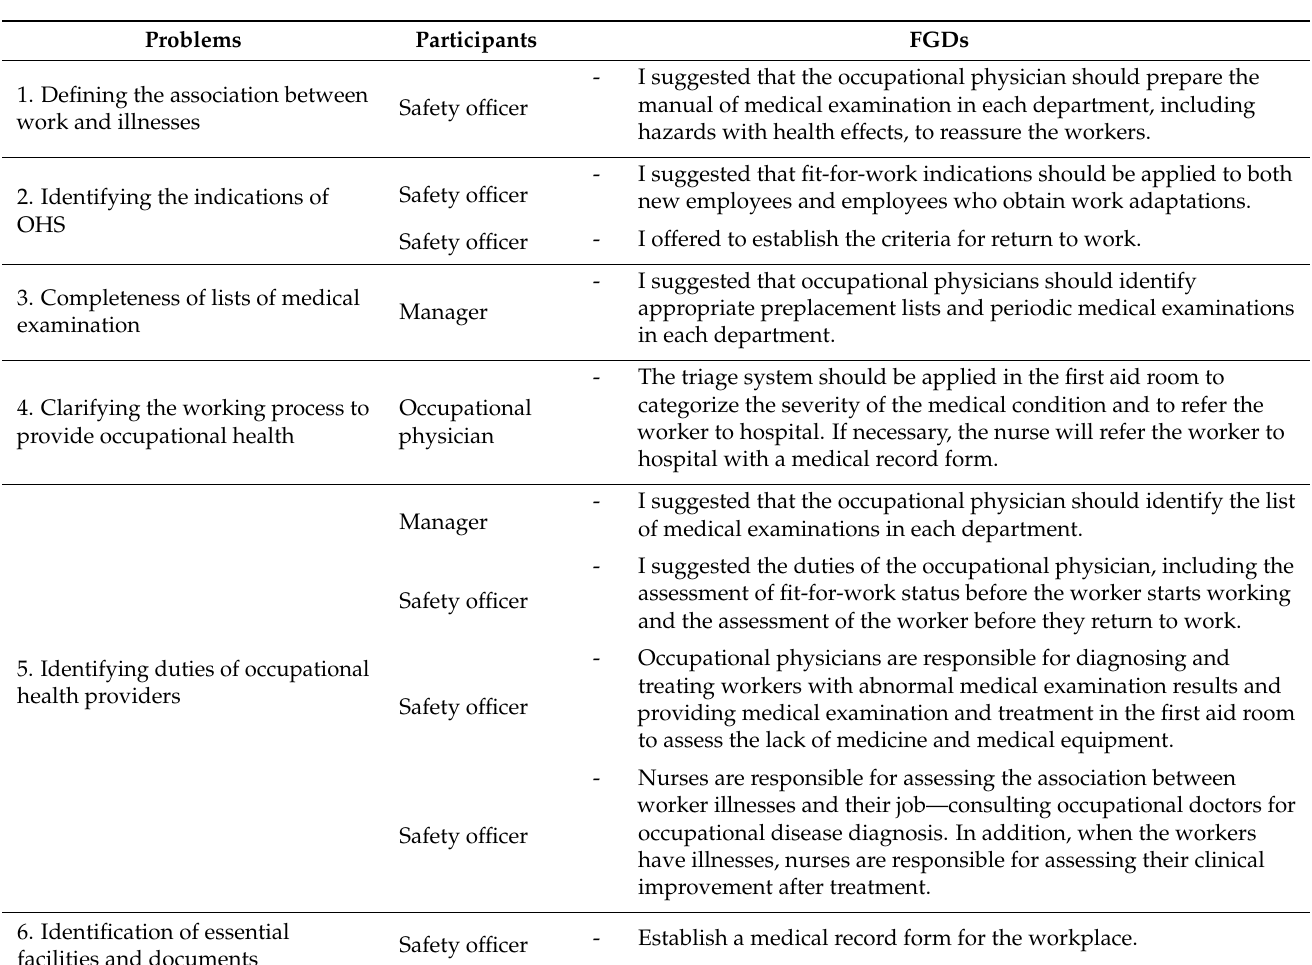
Table 8. The process of developing action